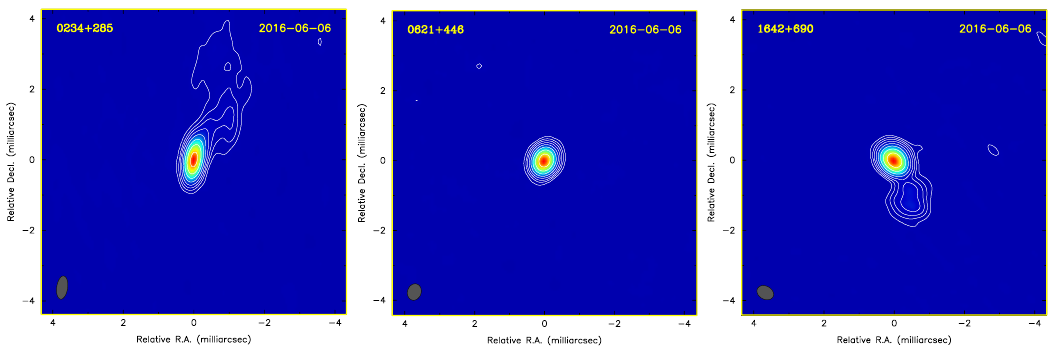
Figure 6. VLBA maps at K-band for three ICRF-3 sources (0234+285, 0621+446, and 1642+690) with compact structure or weak extended emission. The contour levels start at 3 × the background rms brightness level and increase by factors of 2 thereafter. The weak extended emission, visible only in the lower contour levels, has a small impact on the astrometry. See [27] (from which these maps are reproduced) for full details on the map